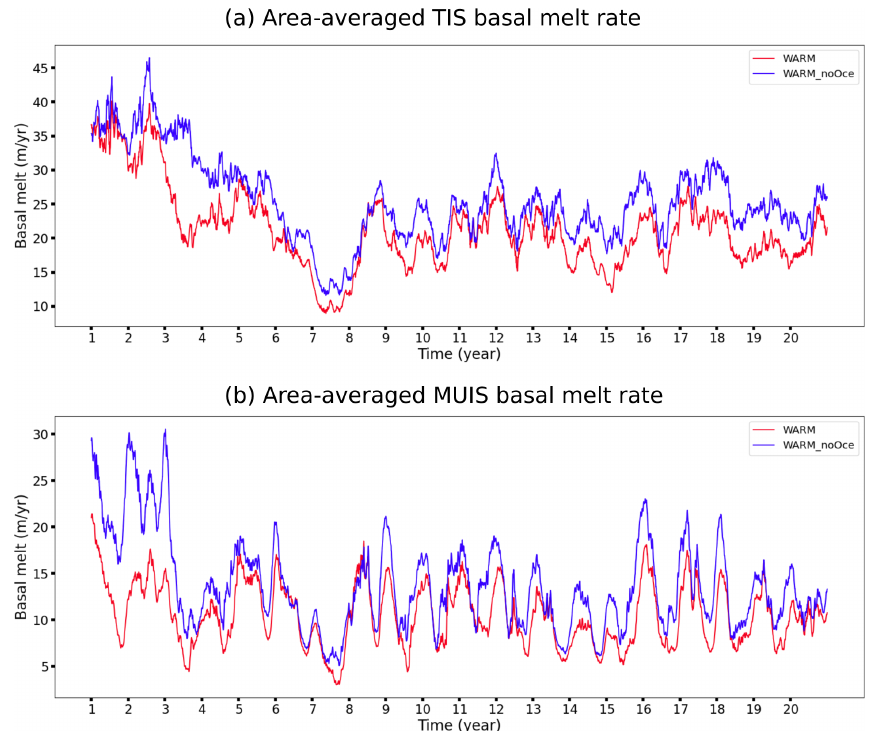
Figure 8. Time series of the area-averaged TIS (a) and MUIS (b) basal melt rates from WARM (red) and WARM_noOce (blue) for the 20 years of simulations.